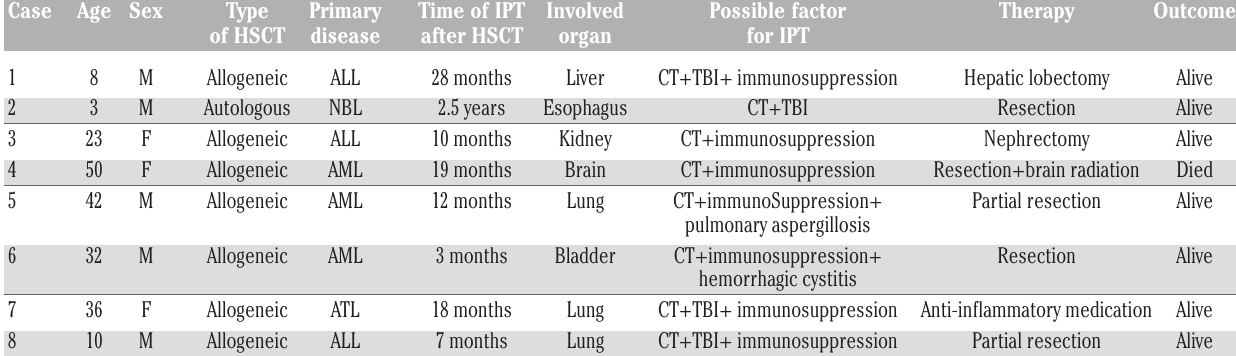
Table 1. Inflammatory pseudotumor of different organs in patients following hematopoietic stem cell